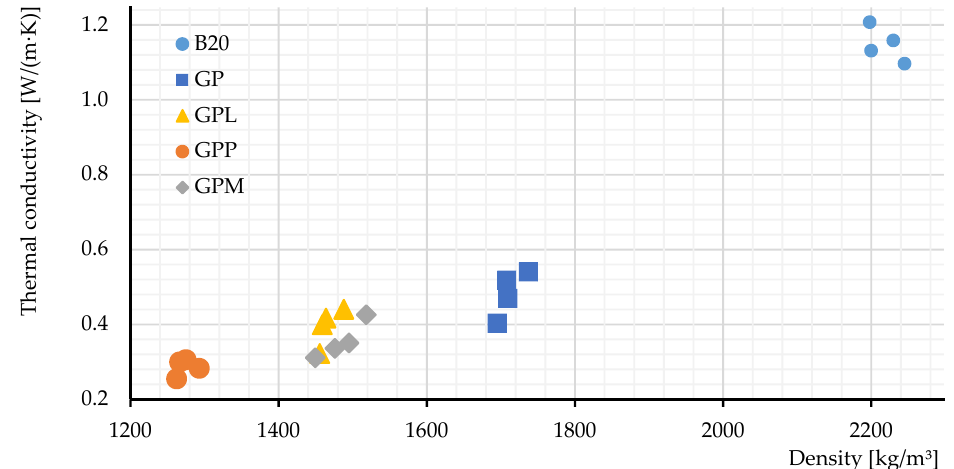
Figure 8. Physical properties of the samples studied.